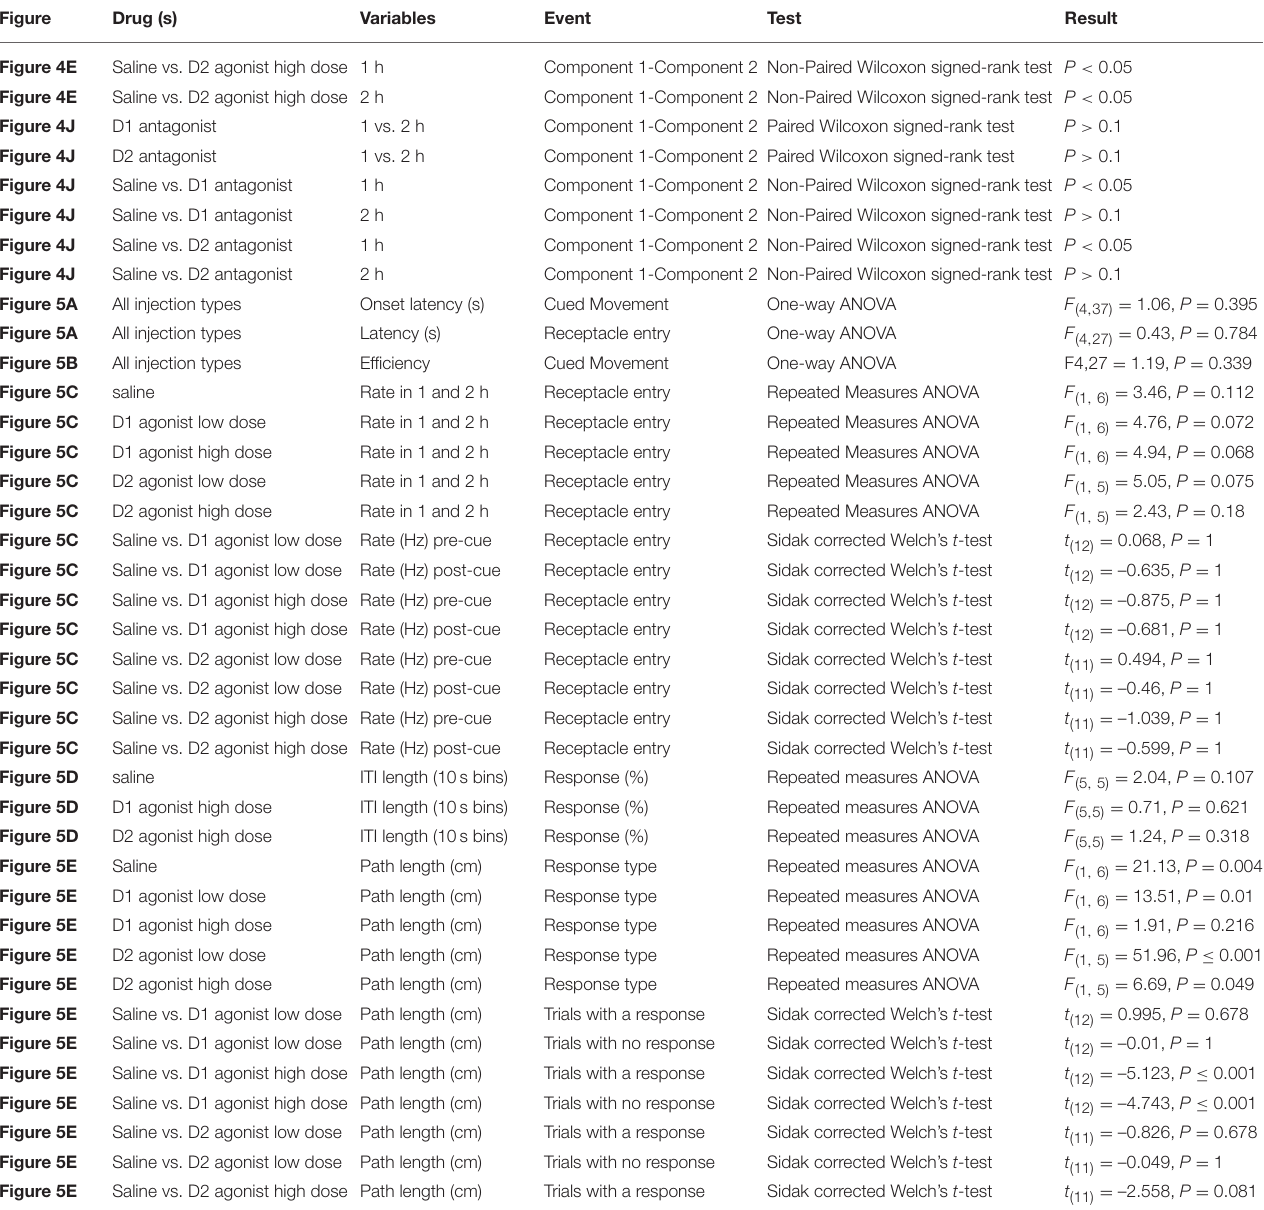
Figure Drug (s) Variables Event Test Result Figure 4E Saline vs. D2 agonist high dose 1 h Component 1-Component 2 Non-Paired Wilcoxon signed-rank test P < 0.05 Figure 4E Saline vs. D2 agonist high dose 2 h Component 1-Component 2 Non-Paired Wilcoxon signed-rank test P < 0.05 Figure 4J D1 antagonist 1 vs. 2 h Component 1-Component 2 Paired Wilcoxon signed-rank test P > 0.1 Figure 4J D2 antagonist 1 vs. 2 h Component 1-Component 2 Paired Wilcoxon signed-rank test P > 0.1 Figure 4J Saline vs. D1 antagonist 1 h Component 1-Component 2 Non-Paired Wilcoxon signed-rank test P < 0.05 Figure 4J Saline vs. D1 antagonist 2 h Component 1-Component 2 Non-Paired Wilcoxon signed-rank test P > 0.1 Figure 4J Saline vs. D2 antagonist 1 h Component 1-Component 2 Non-Paired Wilcoxon signed-rank test P < 0.05 Figure 4J Saline vs. D2 antagonist 2 h Component 1-Component 2 Non-Paired Wilcoxon signed-rank test P > 0.1 Figure 5A All injection types Onset latency (s) Cued Movement One-way ANOVA F (4 , 37) = 1.06, P = 0.395 Figure 5A All injection types Latency (s) Receptacle entry One-way ANOVA F (4 , 27) = 0.43, P = 0.784 Figure 5B All injection types Efficiency Cued Movement One-way ANOVA F4,27 = 1.19, P = 0.339 Figure 5C saline Rate in 1 and 2 h Receptacle entry Repeated Measures ANOVA F (1 , 6) = 3.46, P = 0.112 Figure 5C D1 agonist low dose Rate in 1 and 2 h Receptacle entry Repeated Measures ANOVA F (1 , 6) = 4.76, P = 0.072 Figure 5C D1 agonist high dose Rate in 1 and 2 h Receptacle entry Repeated Measures ANOVA F (1 , 6) = 4.94, P = 0.068 Figure 5C D2 agonist low dose Rate in 1 and 2 h Receptacle entry Repeated Measures ANOVA F (1 , 5) = 5.05, P = 0.075 Figure 5C D2 agonist high dose Rate in 1 and 2 h Receptacle entry Repeated Measures ANOVA F (1 , 5) = 2.43, P = 0.18 Figure 5C Saline vs. D1 agonist low dose Rate (Hz) pre-cue Receptacle entry Sidak corrected Welch’s t -test t (12) = 0.068, P = 1 Figure 5C Saline vs. D1 agonist low dose Rate (Hz) post-cue Receptacle entry Sidak corrected Welch’s t -test t (12) = –0.635, P = 1 Figure 5C Saline vs. D1 agonist high dose Rate (Hz) pre-cue Receptacle entry Sidak corrected Welch’s t -test t (12) = –0.875, P = 1 Figure 5C Saline vs. D1 agonist high dose Rate (Hz) post-cue Receptacle entry Sidak corrected Welch’s t -test t (12) = –0.681, P = 1 Figure 5C Saline vs. D2 agonist low dose Rate (Hz) pre-cue Receptacle entry Sidak corrected Welch’s t -test t (11) = 0.494, P = 1 Figure 5C Saline vs. D2 agonist low dose Rate (Hz) post-cue Receptacle entry Sidak corrected Welch’s t -test t (11) = –0.46, P = 1 Figure 5C Saline vs. D2 agonist high dose Rate (Hz) pre-cue Receptacle entry Sidak corrected Welch’s t -test t (11) = –1.039, P = 1 Figure 5C Saline vs. D2 agonist high dose Rate (Hz) post-cue Receptacle entry Sidak corrected Welch’s t -test t (11) = –0.599, P = 1 Figure 5D saline ITI length (10s bins) Response (%) Repeated measures ANOVA F (5 , 5) = 2.04, P = 0.107 Figure 5D D1 agonist high dose ITI length (10s bins) Response (%) Repeated measures ANOVA F (5 , 5) = 0.71, P = 0.621 Figure 5D D2 agonist high dose ITI length (10s bins) Response (%) Repeated measures ANOVA F (5 , 5) = 1.24, P = 0.318 Figure 5E Saline Path length (cm) Response type Repeated measures ANOVA F (1 , 6) = 21.13, P = 0.004 Figure 5E D1 agonist low dose Path length (cm) Response type Repeated measures ANOVA F (1 , 6) = 13.51, P = 0.01 Figure 5E D1 agonist high dose Path length (cm) Response type Repeated measures ANOVA F (1 , 6) = 1.91, P = 0.216 Figure 5E D2 agonist low dose Path length (cm) Response type Repeated measures ANOVA F (1 , 5) = 51.96, P ≤ 0.001 Figure 5E D2 agonist high dose Path length (cm) Response type Repeated measures ANOVA F (1 , 5) = 6.69, P = 0.049 Figure 5E Saline vs. D1 agonist low dose Path length (cm) Trials with a response Sidak corrected Welch’s t -test t (12) = 0.995, P = 0.678 Figure 5E Saline vs. D1 agonist low dose Path length (cm) Trials with no response Sidak corrected Welch’s t -test t (12) = –0.01, P = 1 Figure 5E Saline vs. D1 agonist high dose Path length (cm) Trials with a response Sidak corrected Welch’s t -test t (12) = –5.123, P ≤ 0.001 Figure 5E Saline vs. D1 agonist high dose Path length (cm) Trials with no response Sidak corrected Welch’s t -test t (12) = –4.743, P ≤ 0.001 Figure 5E Saline vs. D2 agonist low dose Path length (cm) Trials with a response Sidak corrected Welch’s t -test t (11) = –0.826, P = 0.678 Figure 5E Saline vs. D2 agonist low dose Path length (cm) Trials with no response Sidak corrected Welch’s t -test t (11) = –0.049, P = 1 Figure 5E Saline vs. D2 agonist high dose Path length (cm) Trials with a response Sidak corrected Welch’s t -test t (11) = –2.558, P =